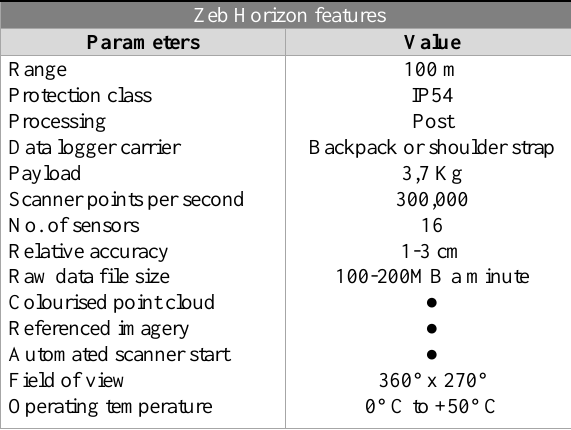
Table 1 . Technical specification of the Geo